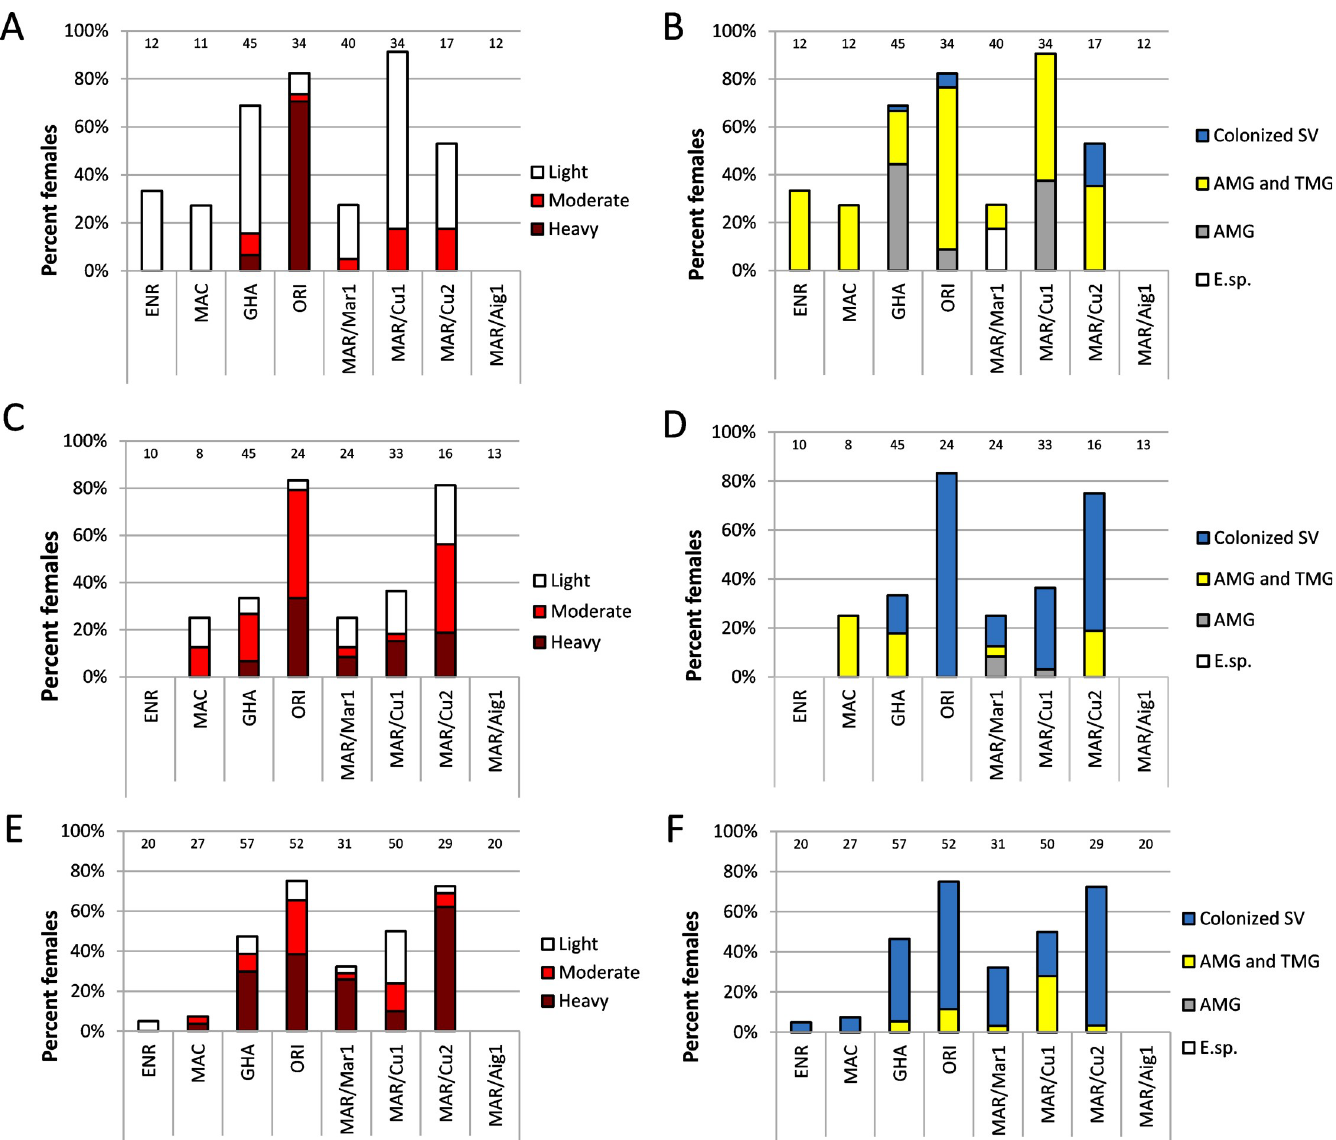
Fig 5. Mundinia development in the biting midge C . sonorensis . Intensity (A, C, E) and localization (B, D, F) of L . enriettii (ENR), L . macropodum (MAC), L . sp. strain GH5 from Ghana (GHA), L . orientalis (ORI) and L . martiniquensis (MAR/MAR1, MAR/Cu1, MAR/Cu2, MAR/Aig1) infections assessed by light microscopy. SV, stomodeal valve; AMG, abdominal midgut; TMG, thoracic midgut; E. sp., endoperitrophic space; PBM, post blood meal. Intensity of infection (parasite load) was categorized as light, < 100 parasites per gut; moderate, 100–1000 parasites per gut and heavy, > 1000 parasites per gut. Numbers of dissected females are written above the columns. Differences among Leishmania species/strains were significant on day 3 PBM (P < 0.0001, X 2 = 181.173, d.f. = 21), day 6 PBM (P < 0.0001, X 2 = 70.048, d. f. = 21) and day 10 PBM (P < 0.0001, X 2 = 117.932, d.f. =